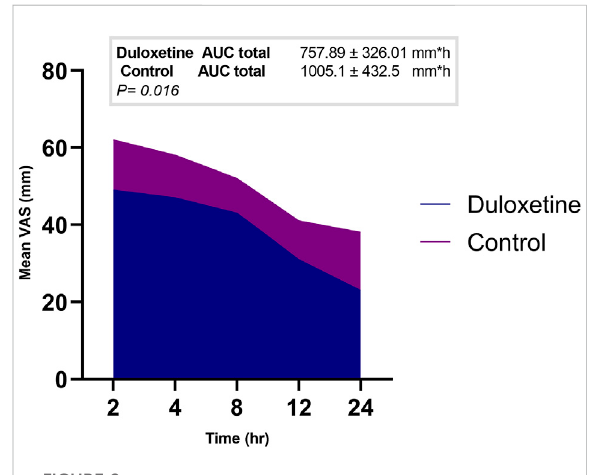
FIGURE 2 Area graph representing the mean VAS score at the different time intervals in the two